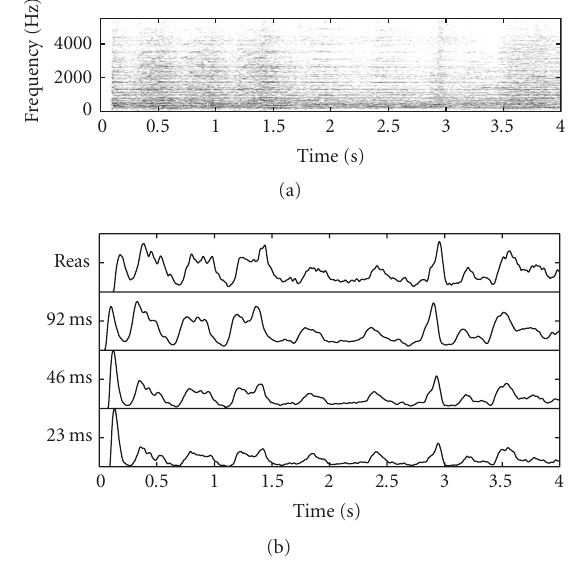
Figure 3: Same as Figure 2 but on [signal: Bernstein conducts Stravinsky, track 23 “The jovial merchant with two gypsy girls” from the “songs” database of the ISMIR 2004 test